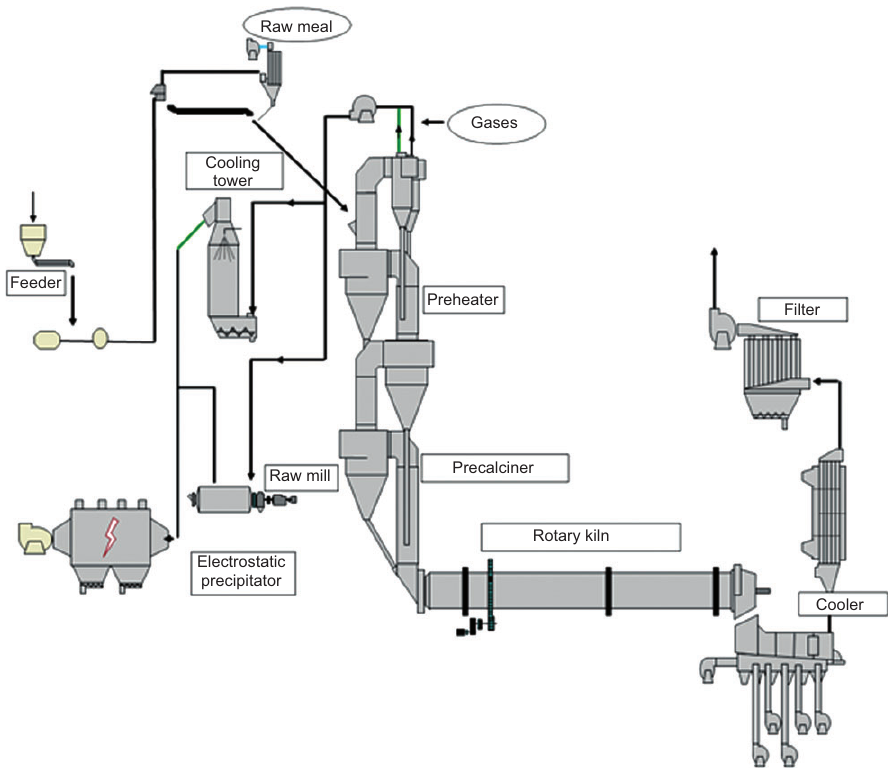
Figure 2 Rotary kiln for clinker production.